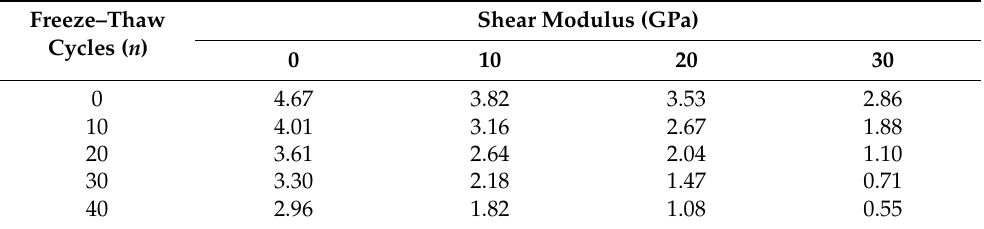
Table 3. Variation in the shear modulus of joint specimens with freeze–thaw